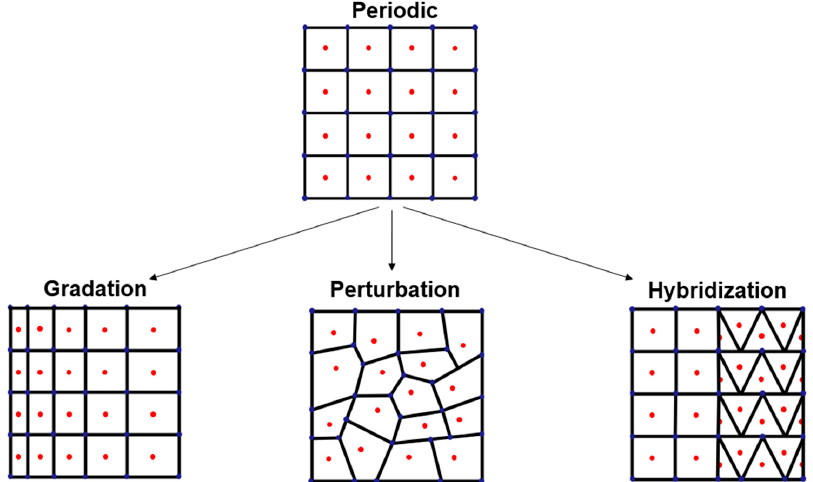
Figure 3. Aperiodic cellular materials as emergent from a periodic template, with three main types: gradation, perturbation, and hybridization. Red dots indicate cell nuclei, while black lines indicate cell members.